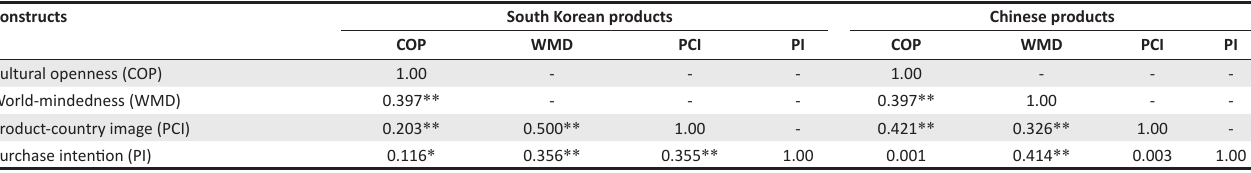
TABLE 4: Correlation analysis